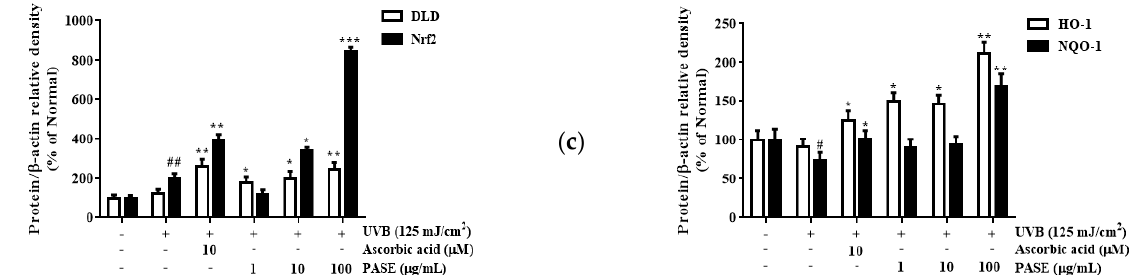
Figure 7. PASE stimulated the Nrf2/ARE-signaling protein levels in UVB-exposed HaCaT cells: Phosphorylated and non-phosphorylated forms of DLD, Nrf2, HO-1, and NQO-1 ( a ); the band intensities ( b , c ). Data are shown as means ± SDs of three independent experiments. # p < 0.05, ## p < 0.01, compared with non-exposed group, * p < 0.05, ** p < 0.01, *** p < 0.001 compared with only UVB-exposed group.